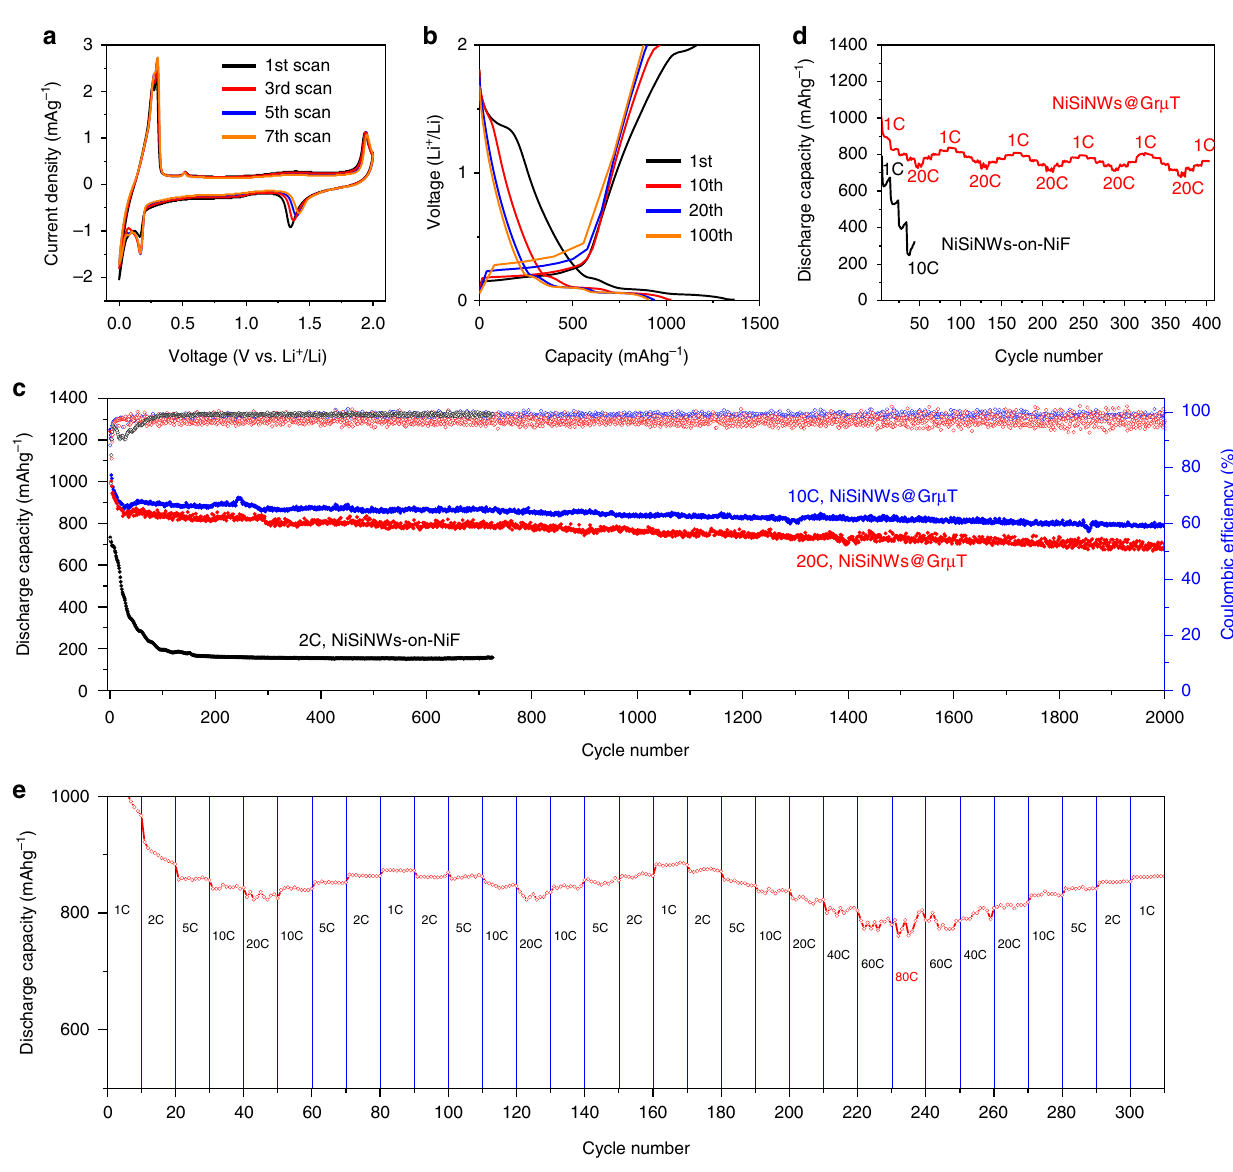
Fig. 3 Electrochemical analysis of NiSiNWs@Gr μ T. a CV pro fi les of NiSiNWs@Gr μ T during sweeps over the range from 2.0 to 0.0 V vs. Li/Li + at a rate of 0.1 mV s − 1 . b Galvanostatic charge-discharge pro fi les of NiSiNWs@Gr μ T for the 1st, 10th, 20th, and 100th cycles. c Capacity of NiSiNWs@Gr μ T cycled at the discharging rate while undergoing stepwise changes from 1C to 20C. The NiSiNWs-on-NiF is used for comparison (black). d Discharge capacity (solid circles) and coulombic ef fi ciency (open circles) of NiSiNWs@Gr μ T at 10C (black) and 20C (red) for 2000 cycles. The same plots of NiSiNWs-on-NiF at 2C (blue). e Rate capability test of NiSiNWs@Gr μ T with various cycling rates from 1C to 80C. All tests were performed using 1.0 M LiPF 6 in EC/DEC (1:1) as the electrolyte, in the potential window between 0.0 V and 2.0 V (vs. Li/Li + ). All the capacities are represented based on the weight of